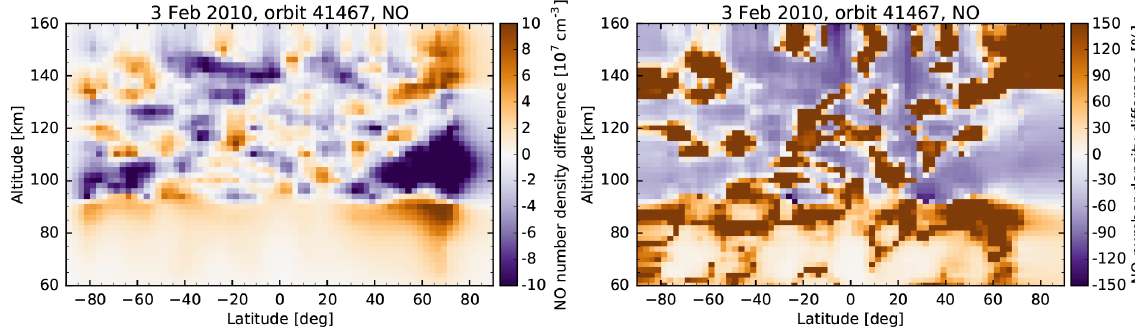
Figure 3. Absolute NO number density differences (left) and relative differences (right) from the SCIAMACHY MLT mode limb scans restricted to 50–91km and zero a priori input compared to the full retrieval (sample orbit no. 41467, 3 February 2010).